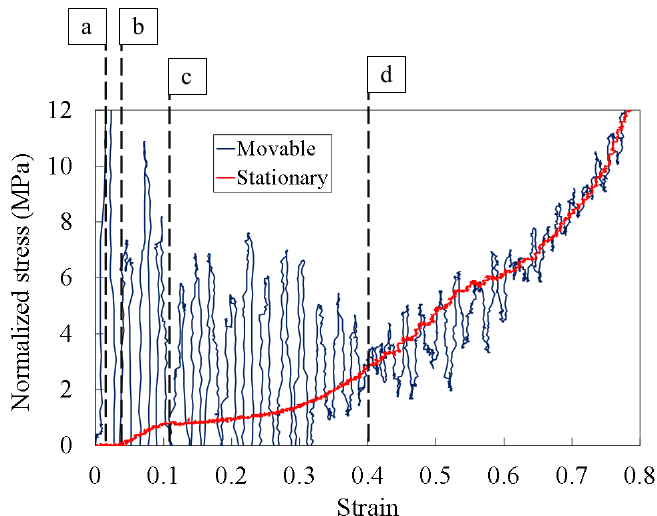
Figure 13. Typical normalized stress–strain relationship of Ni foam in an impact test conducted at compression rate of approximately 26.0 m/s.